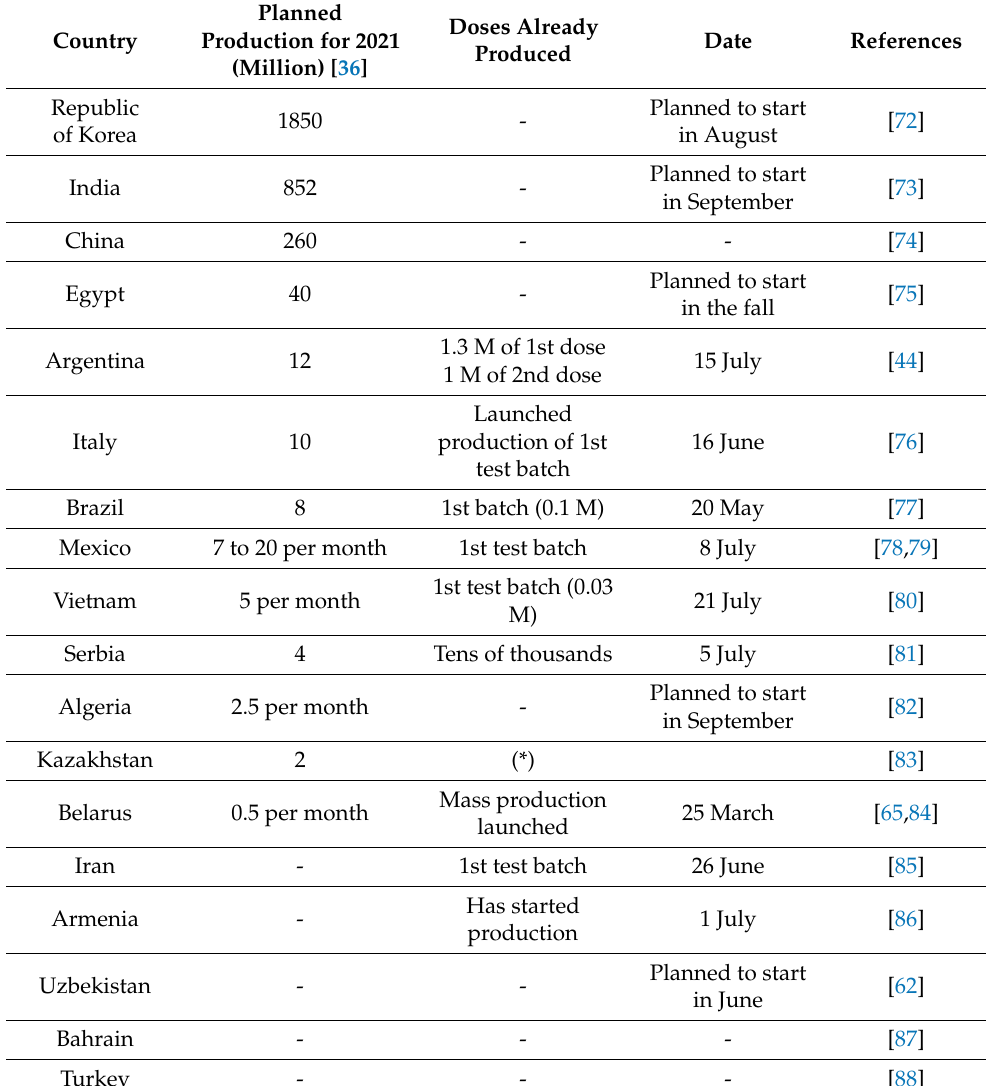
Table 3. Number of doses of Sputnik V to be produced abroad and number of doses already produced abroad as of 31 July